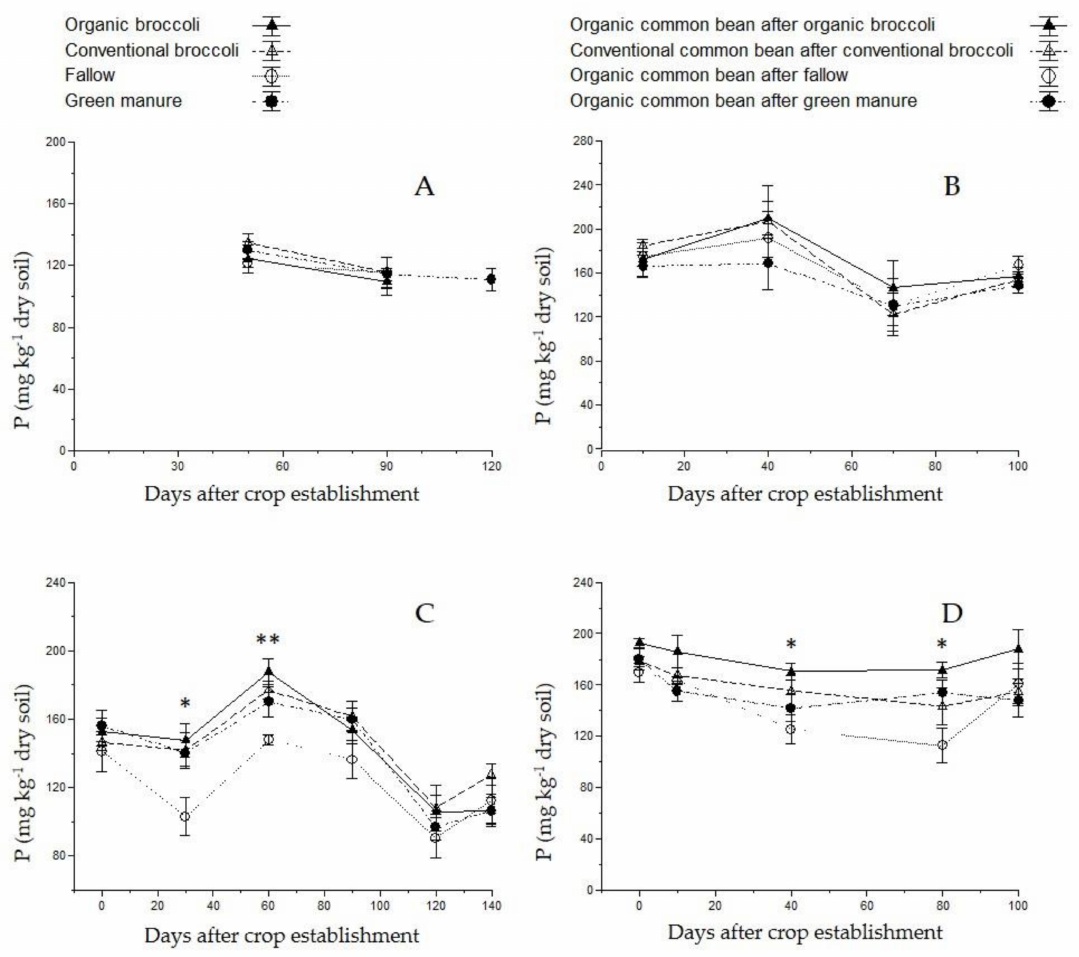
Figure 7. Impact of pre-crop treatments during the wintertime on P concentration in the soil during the two experimental years. Vertical bars indicate standard errors of means (n = 8), while * and ** indicate significant di ff erences according to Duncan’s multiple range test ( p < 0.05), significant at p < 0.05 and p < 0.01, respectively. ( A ) Soil P concentrations in the di ff erent treatments applied as preceding crops during autumn-winter 2017–2018, particularly at 50, 90, and 120 days after crop establishment (DACE). ( B ) Soil P concentrations after crop establishment, at the 50% flowering stage, during harvest, and at crop termination (10, 40, 70, and 100 DACE) in the common bean crop during spring-summer 2018, as influenced by the preceding winter crop. ( C ) Soil P concentrations before basal dressing, after crop establishment, at the stage of broccoli flower head formation, at crop termination of broccoli, at 50% flowering of faba bean, and after incorporation of plant residues into the soil (0, 30, 60, 90, 120, and 140 DACE) in the di ff erent treatments applied as preceding crops during autumn-winter 2018–2019. ( D ) Soil P concentrations before and after the establishment of common bean crop, at the 50% flowering stage, at harvest, and at crop termination (0, 10, 40, 80, and 100 DACE, respectively) during spring-summer 2019, as influenced by the preceding winter